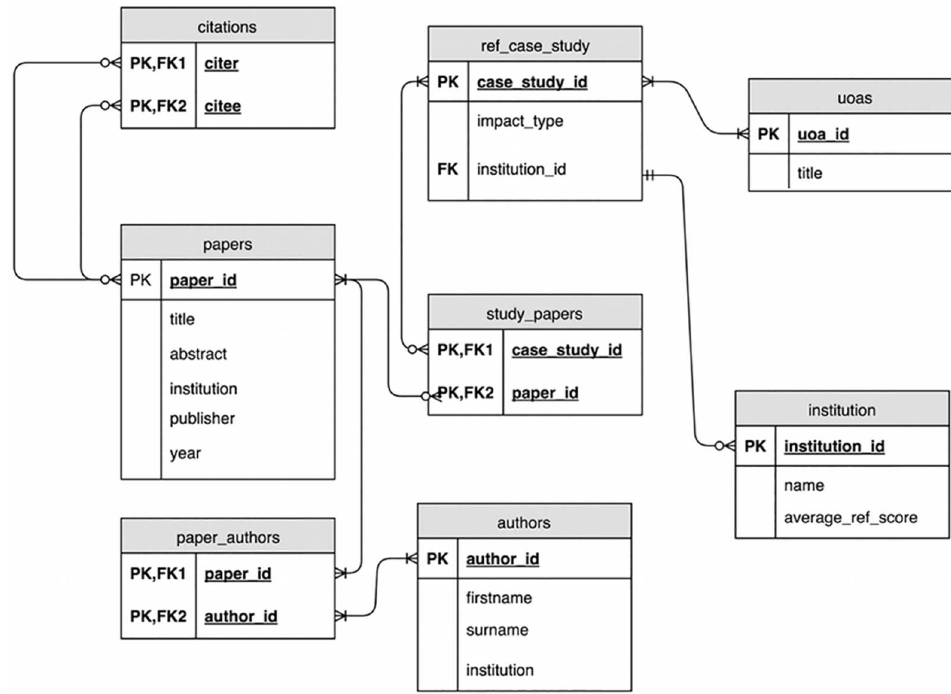
Fig 1. Entity relationship diagram describing how relationships between publications (papers), REF studies, institutions, authors and inter-paper citations.